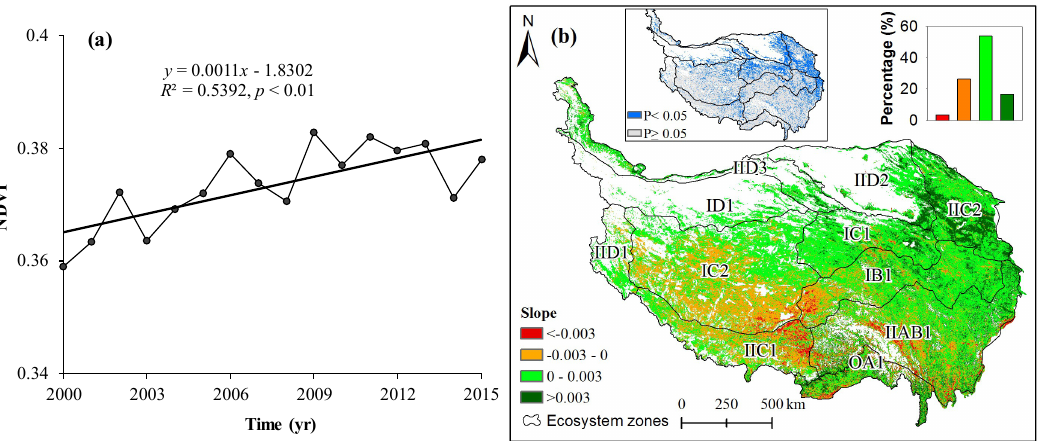
Figure 2. Inter-annual change of growing season NDVI (GNDVI) on the Tibetan Plateau (TP), ( a ) the area-averaged GNDVI trend, ( b ) the spatial patterns of GNDVI trends. Insets in the top of panel ( b ) show the significance level of the trends and the percentage of the pixels in each interval of trend indicated by the color in the legend in the left bottom.